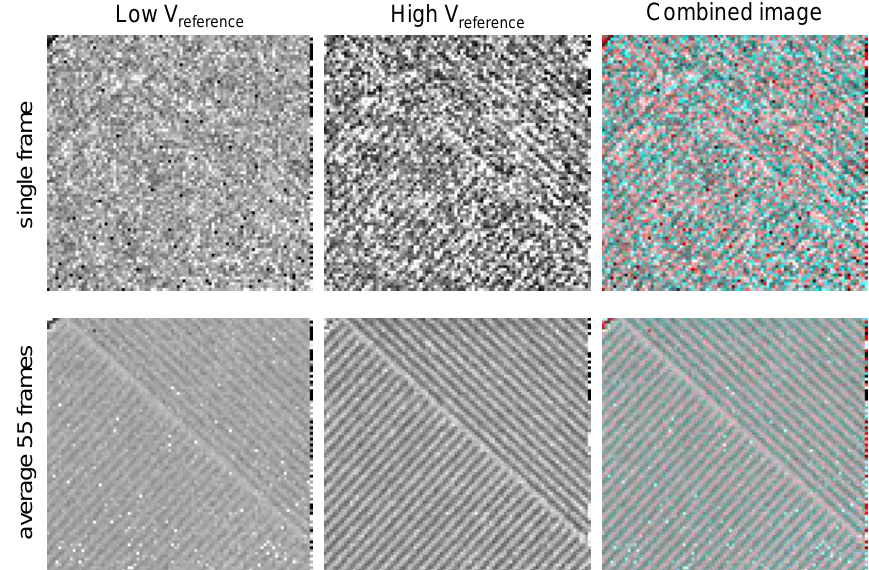
Figure 12. One pixel, two thresholds, observed over a time comprising 180 frames. Beam powers on at frame 9 and powers off after frame 170. ( a ) Counts versus frame number; ( b ) Horizontal histogram of the occurrences of analog count values. Thin red and blue lines are theoretical Poisson distributions with the same average counts.